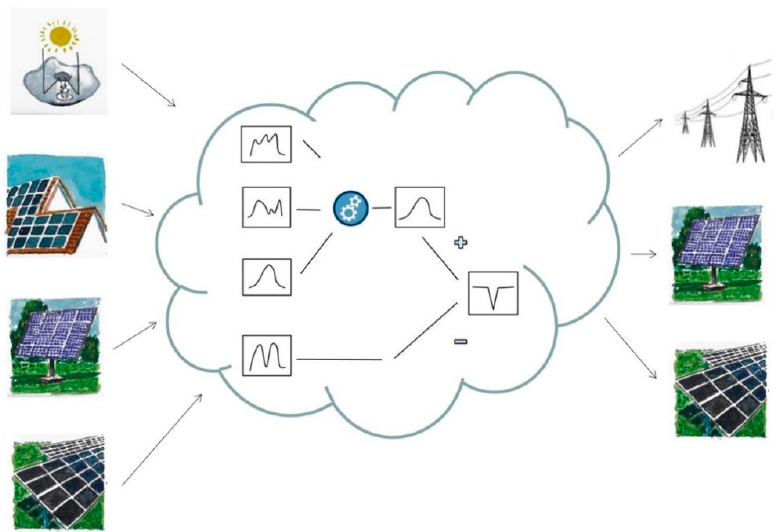
Figure 1. Conceptual framework of our work.